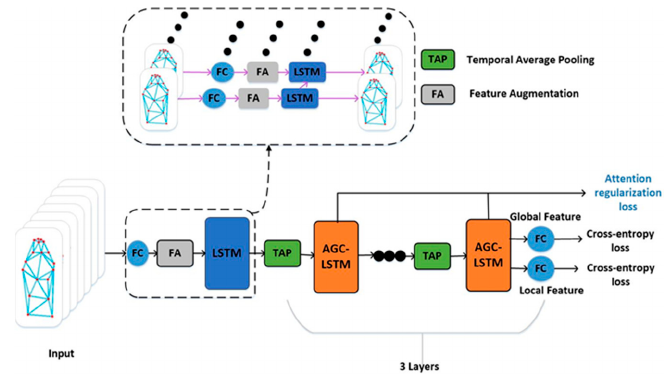
Figure 6. The architecture of the proposed ASTGC-LSTM network.